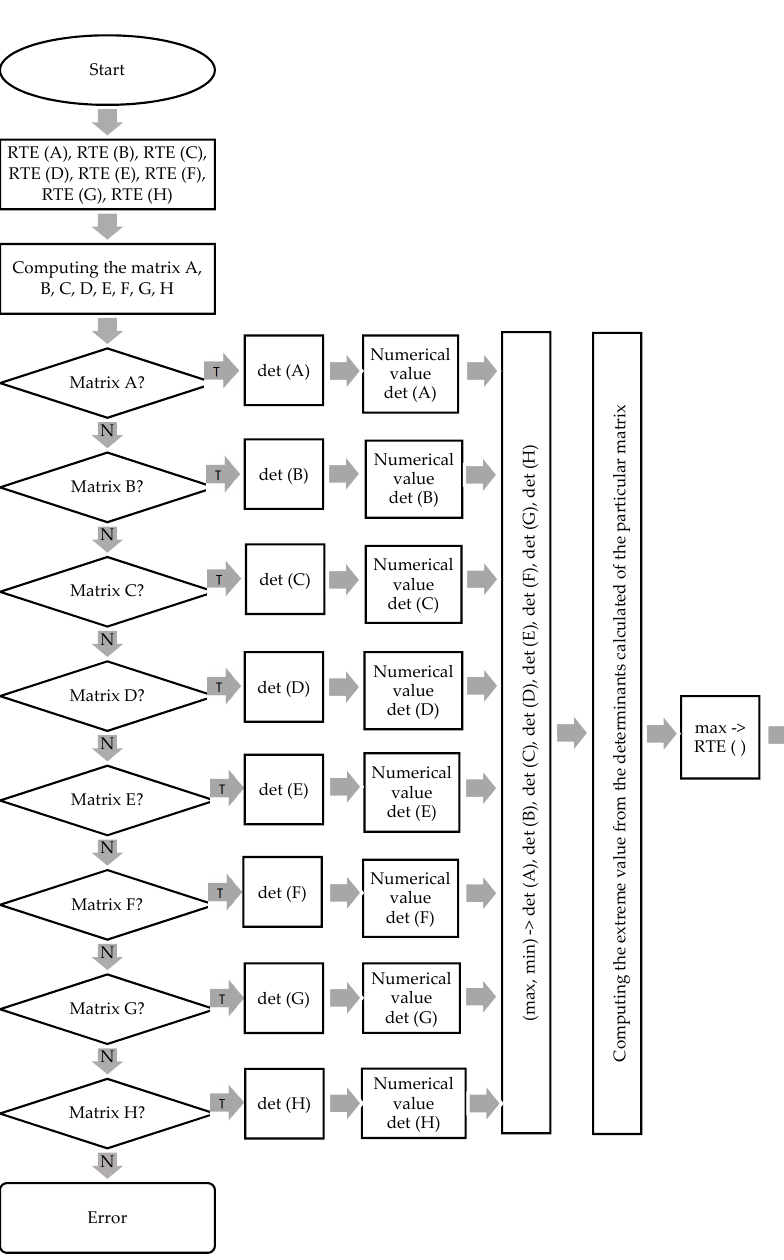
Figure 14. The algorithm for determining the researched RTEs with the highest and the lowest numerical values of the matrix determinants.